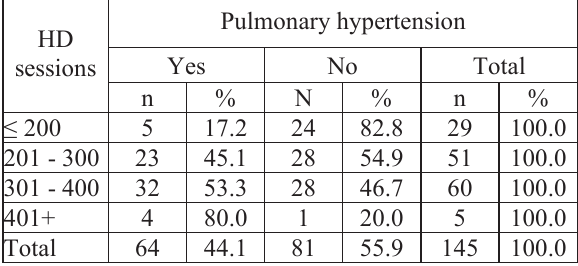
Table-3: Stratification of Pulmonary Hypertension with